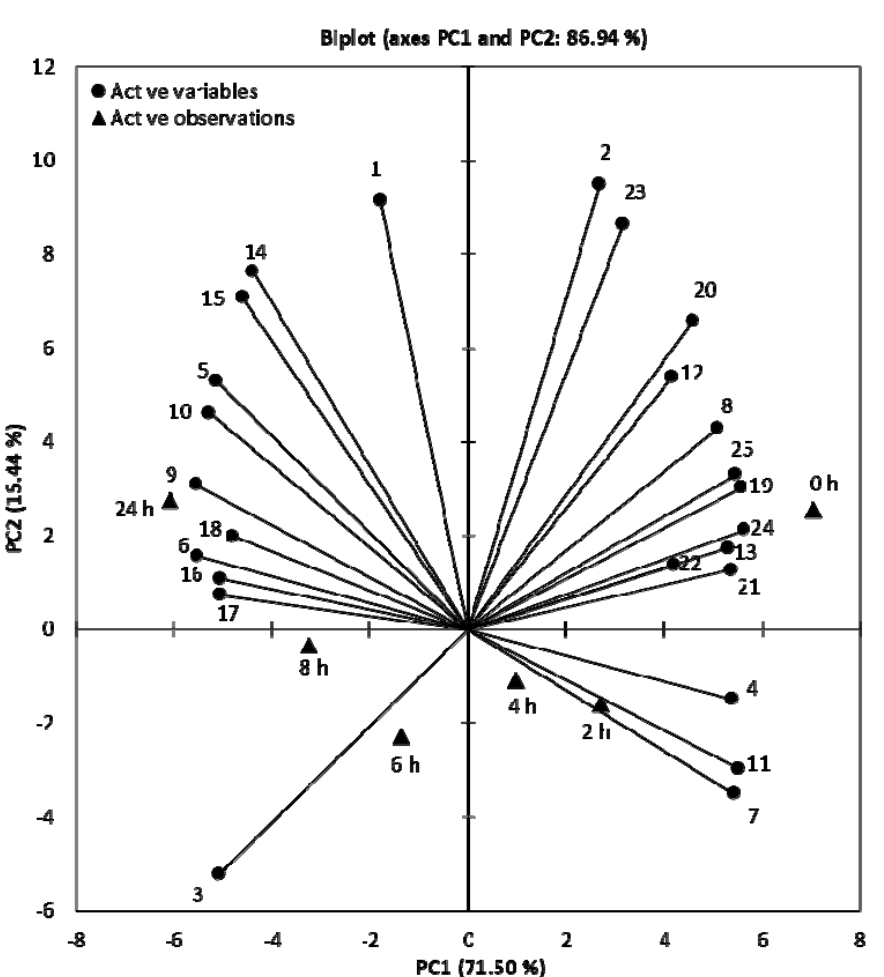
Figure 3. Bi-plot of the PCA analysis performed on the determined 25 variables of pomegranate leaf infusion over one-day storage. Loading plots (vectors representing active variables) and scores plots (triangles representing active observations-different storage times) of PC1 and PC2. Numbers of vectors represented: (1) gallic acid, (2) flavan-3-ols, (3) punicalin, (4) ellagic acid derivative, (5) ellagitannin I, (6) ellagitannin II, (7) ellagitannin III, (8) ellagitannin IV, (9) flavonol glycoside, (10)